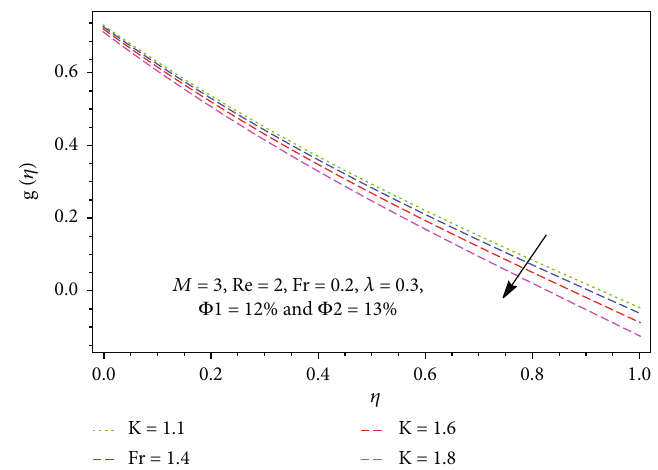
M = 3, Re = 2, Fr = 0.2, 𝜆 = 0.3, Ф 1 = 12% and Ф 2 =